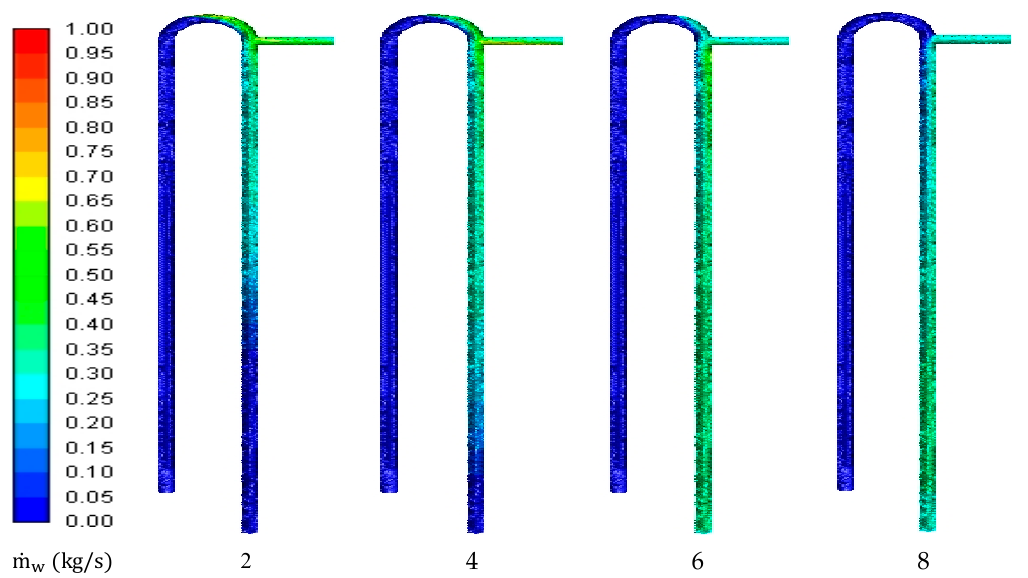
Figure 18. Air volume fraction contours at different flow ratios and X (cid:2933) = 662.96, α (cid:2923) = 0.7 , X (cid:2932) = 0.5 .